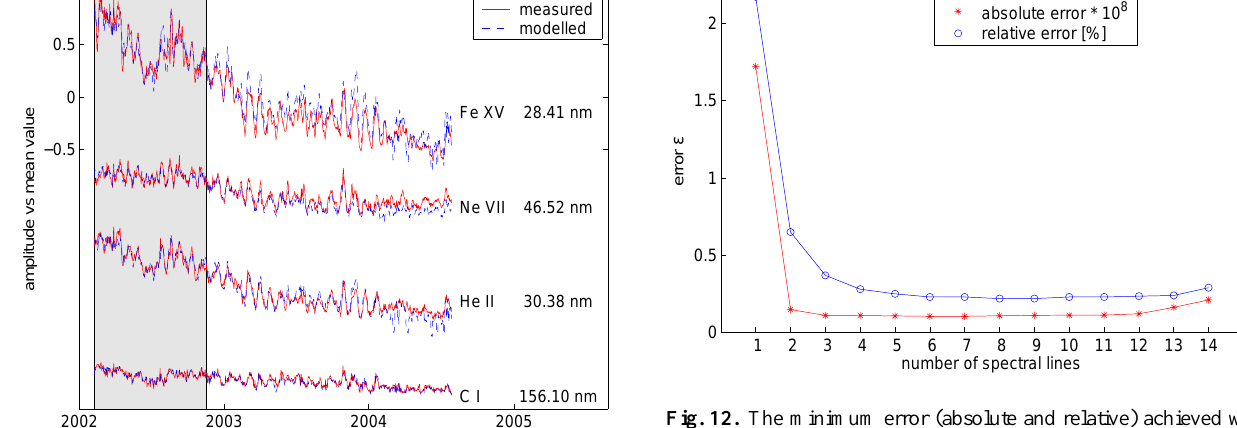
Fig. 12. The minimum error (absolute and relative) achieved with the best combination of 1 up to 14 lines. Also shown (on the far right), are the errors obtained by fitting the spectrum using the two best proxies (Mg II index and F10.7